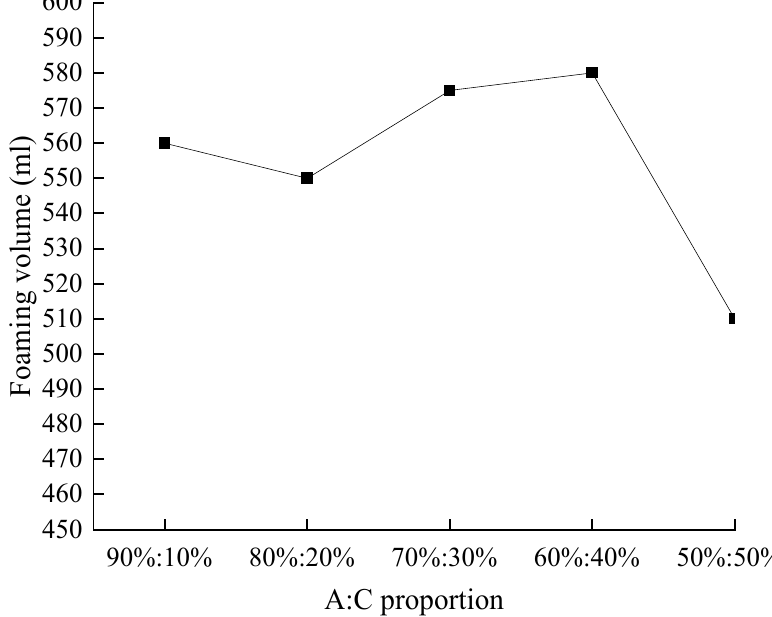
Figure 5. A/C Complex System Foaming Volume Diagram.